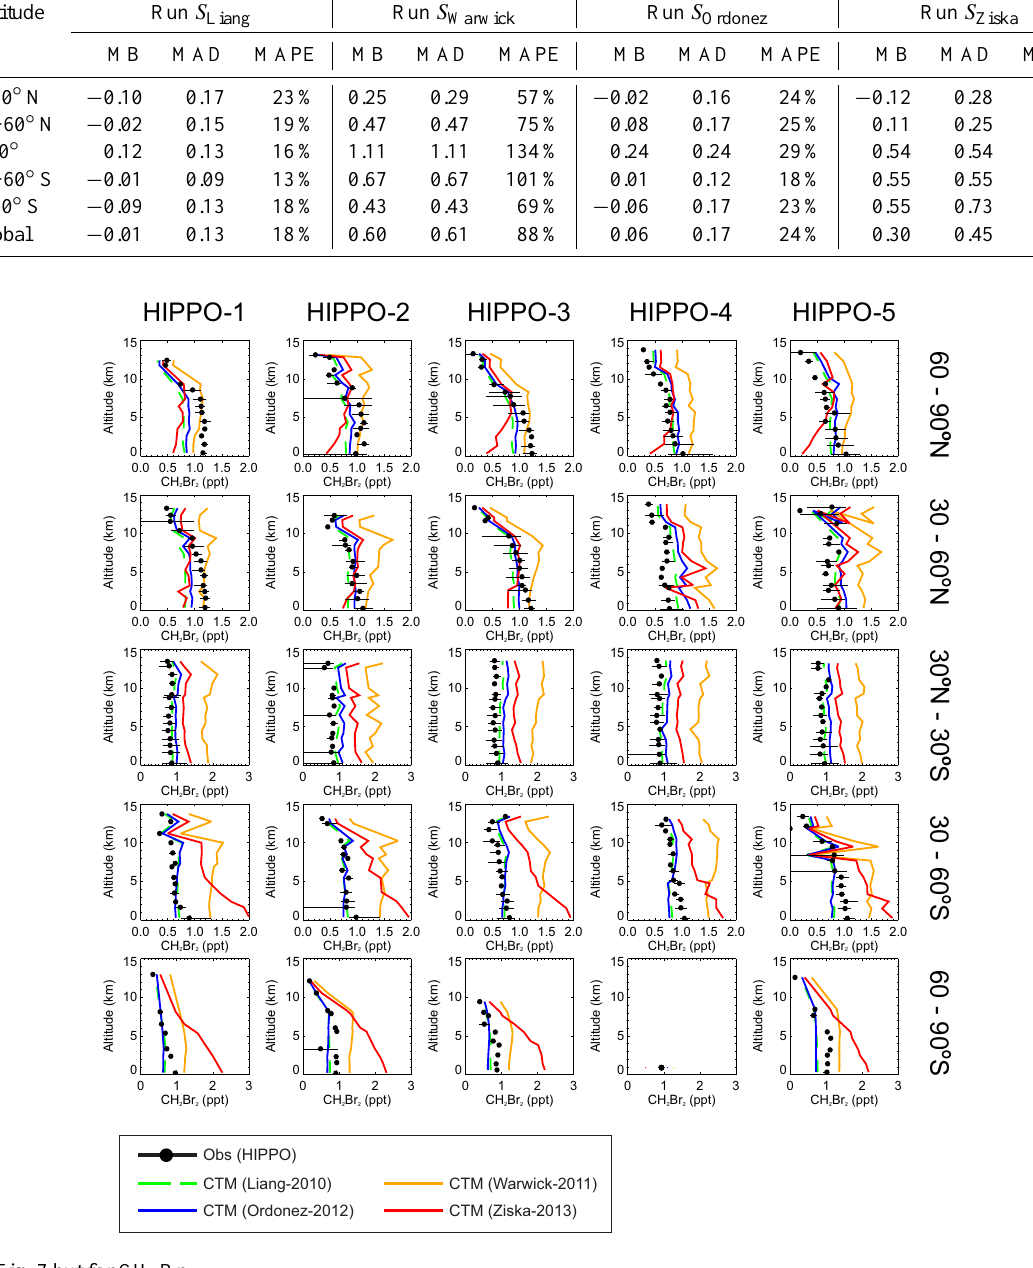
Fig. 8. As Fig. 7 but for CH 2 Br 2